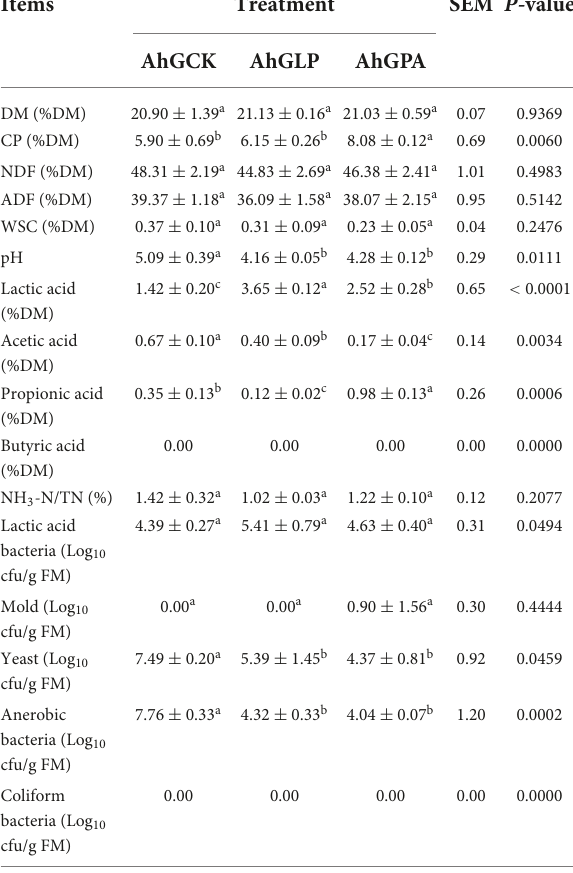
TABLE 2 Chemical compositions, fermentation characteristics, and microbial populations on 60 days of ensiling.